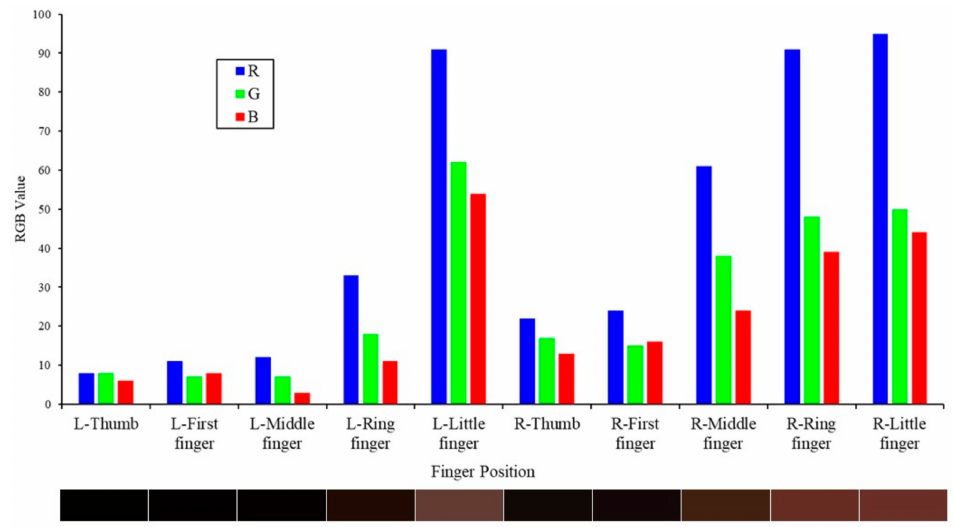
Figure 5. Quantification of the blackening of the fingertips as indicated by the RGB values after propagating 190 fragments of S. flexibilis . The horizontal color bar at the bottom is the color of the sum of the RGB